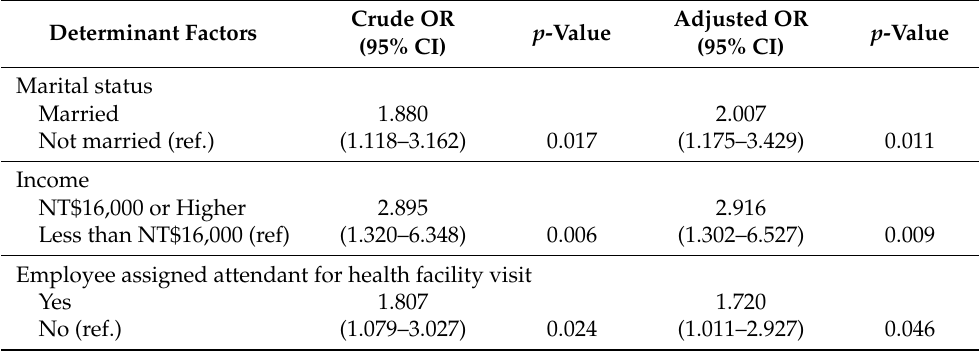
Table 4. Factors associated with access to health services using univariate and multivariate analysis ( n =